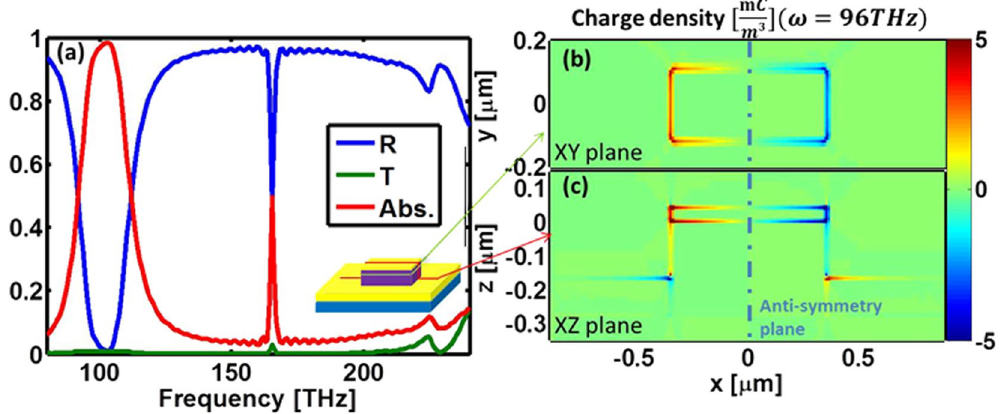
Figure 2. Linear response. ( a ) Linear characterization of an array of cuboid resonators: reflection (R), transmission (T), and absorption (Abs.). (inset) Schematic of the structure with colored lines denoting the locations of the slices of panels ( b ) and ( c ). ( b , c ) Total charge density oscillating at the fundamental frequency. The axes correspond to Fig. 1. The anti-symmetry plane created by the excitation is denoted with the vertical, blue dot-dash